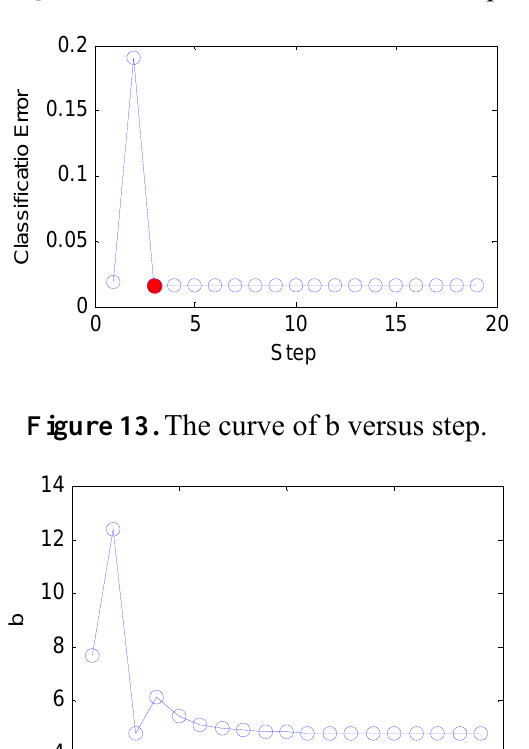
Figure 12. The curve of error versus step.